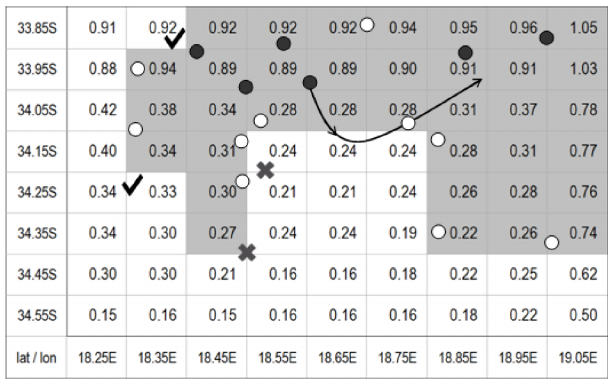
Table 2. Relative influence of surface weather observations in model assimilation, with grey land mask. Stations reporting